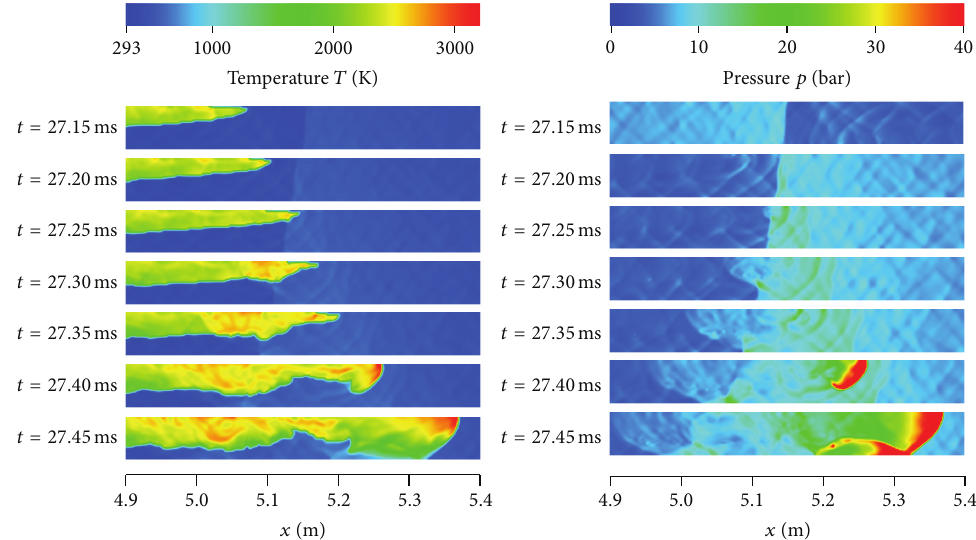
Figure 9: Visualization of a DDT caused by interaction of the flame with a reflected shock.